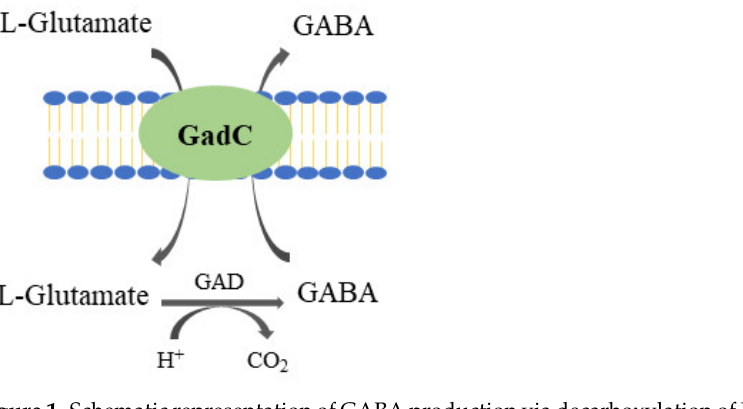
Figure 1. Schematic representation of GABA production via decarboxylation of L-glutamate cata- lyzed by glutamate decarboxylase. GAD, glutamate decarboxylase; GadC, glutamate/GABA anti- porter.